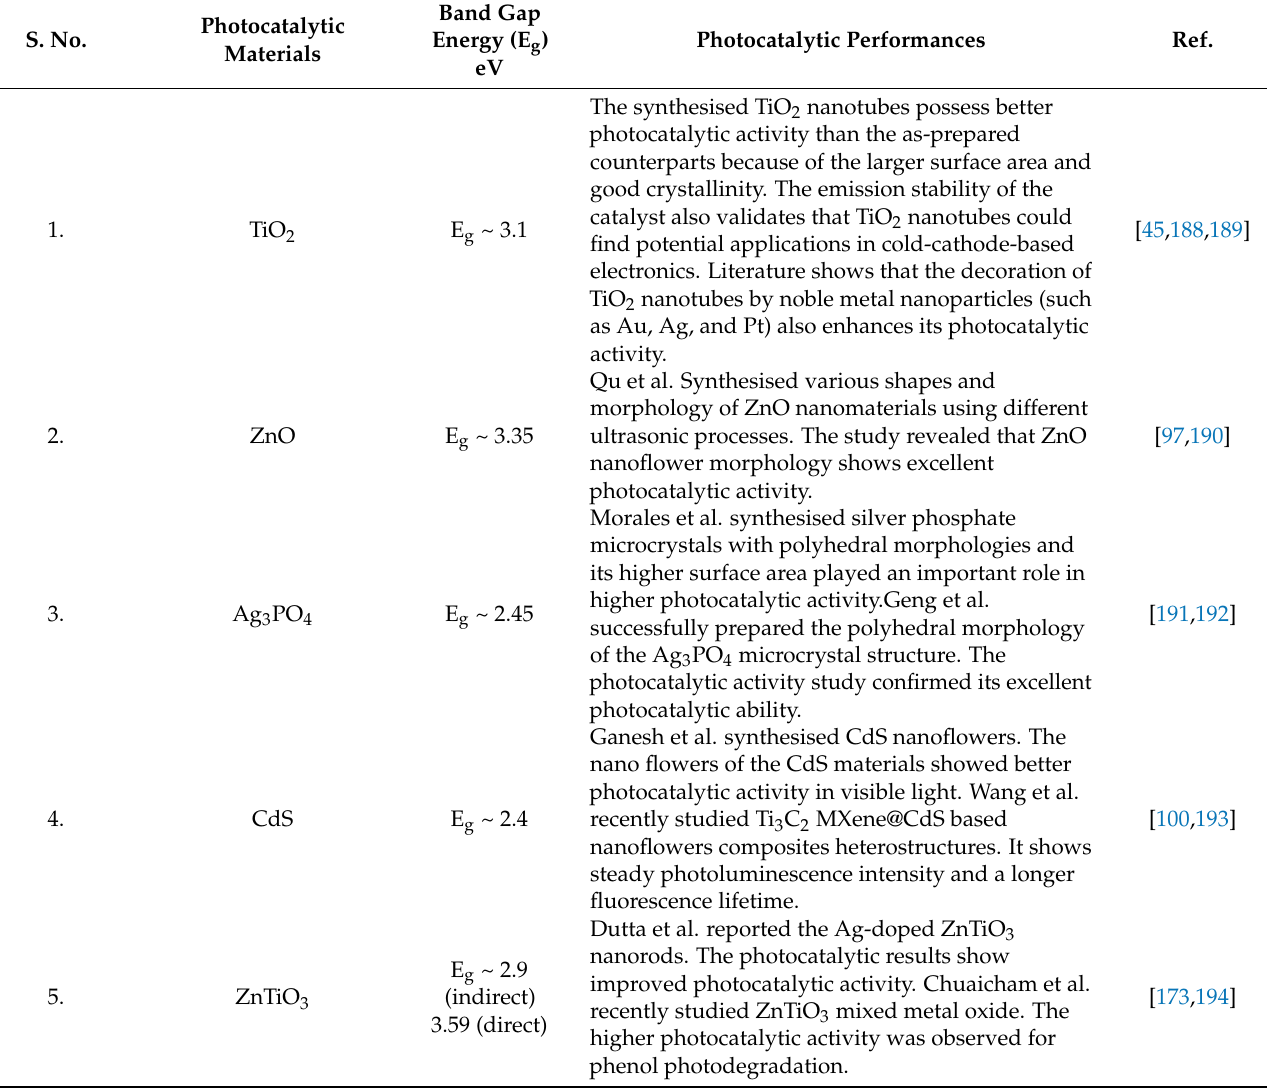
Table 7. Important characteristics of photocatalyst TiO 2 , ZnO, Ag 3 PO 4 , CdS and ZnTiO 3 .